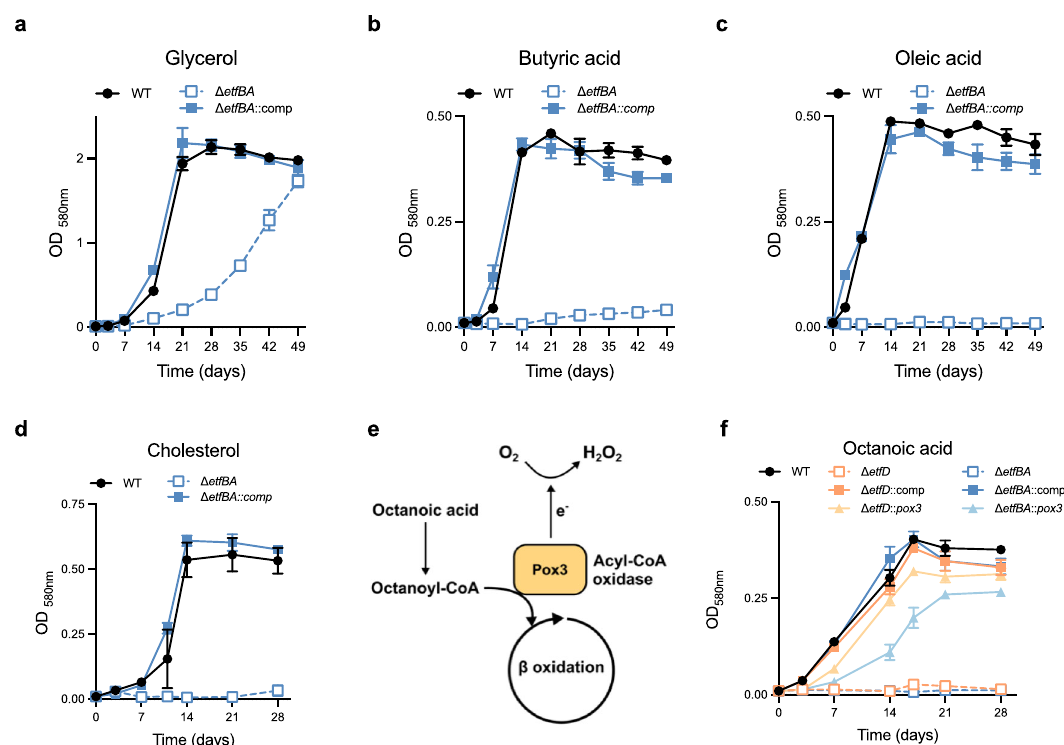
2.5 mM ( b ), oleic acid 250 μ M ( c ), and cholesterol 250 μ M ( d ) as single carbon sources. Oleic acid was replenished every 3 – 4 days for the fi rst 14 days of averages of three replicates and are representative of three independent experiments. Error bars correspond to standard deviation. “ Comp ” stands for complemented. e Diagram representing acyl-coA oxidase activity on octanoic acid. f Rescue of Δ etfD and Δ etfBA growth with 250 μ M octanoic acid as sole carbon source with the expression of the acyl-CoA oxidase Pox3. Octanoic acid was replenished every 3 – 4 days for the fi rst 14 days of culture to support growth and minimize toxicity. Data are averages of three replicates and are representative of three independent experiments. Error bars correspond to standard deviation. “ Comp ” stands for